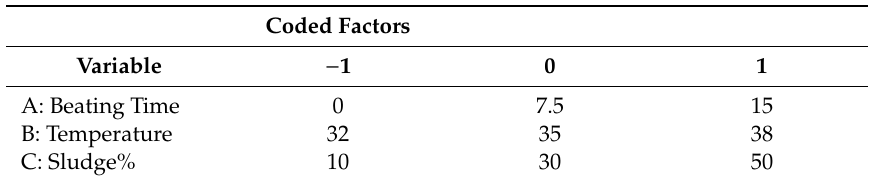
Table 10. Coding format of the variables.